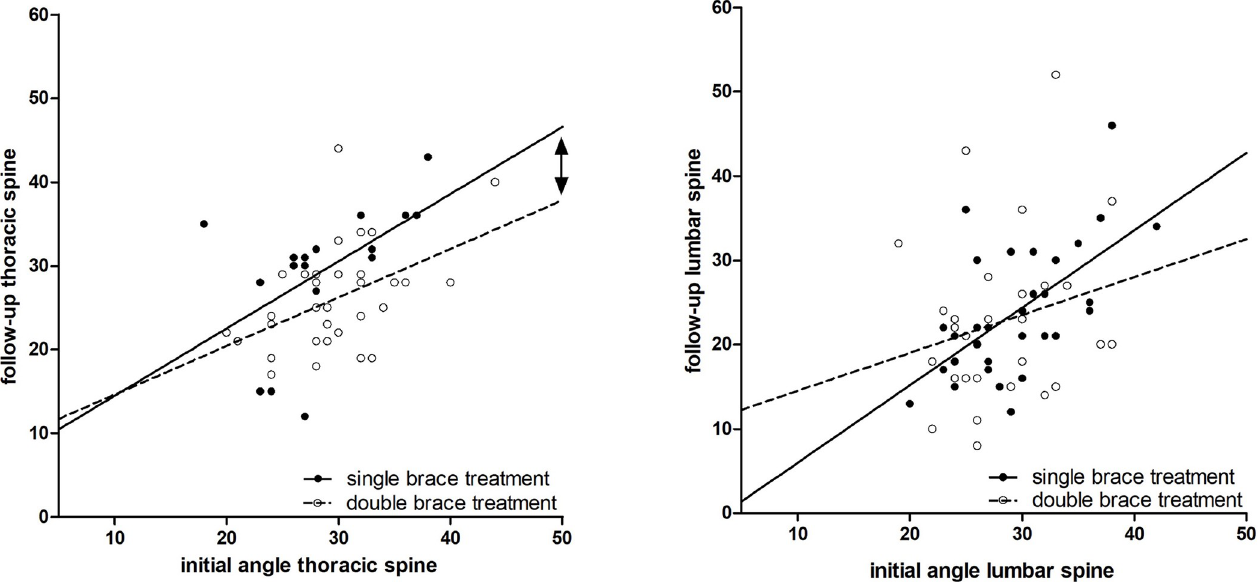
Fig 5. Follow-up Cobb angle (degree) in relation to the initial Cobb angle of the thoracic (left) and lumbar (right) spine, left: initial angle thoracic spine 29 ± 4, follow-up single brace 29 ± 8, double brace 25.94 ± 5.98, right: initial angle lumbar spine 29 ± 5, follow-up single brace 24 ± 8, double-brace 23 ± 10 (mean ± standard